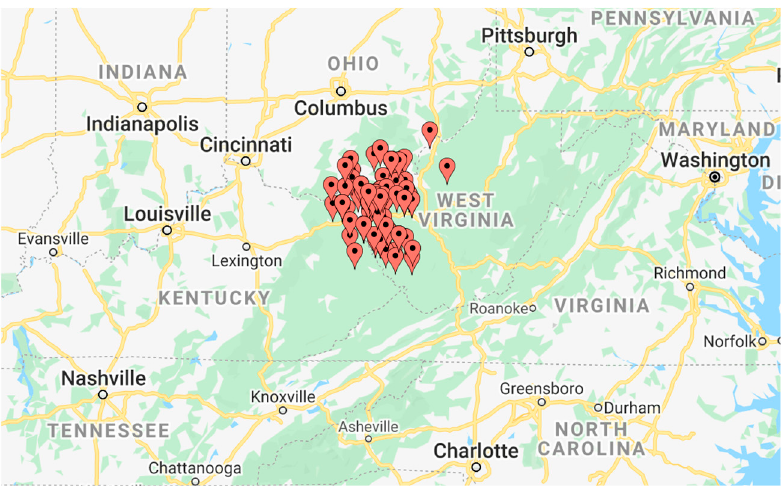
Figure 1. Map of subjects depicted on U.S. map of Eastern United States.